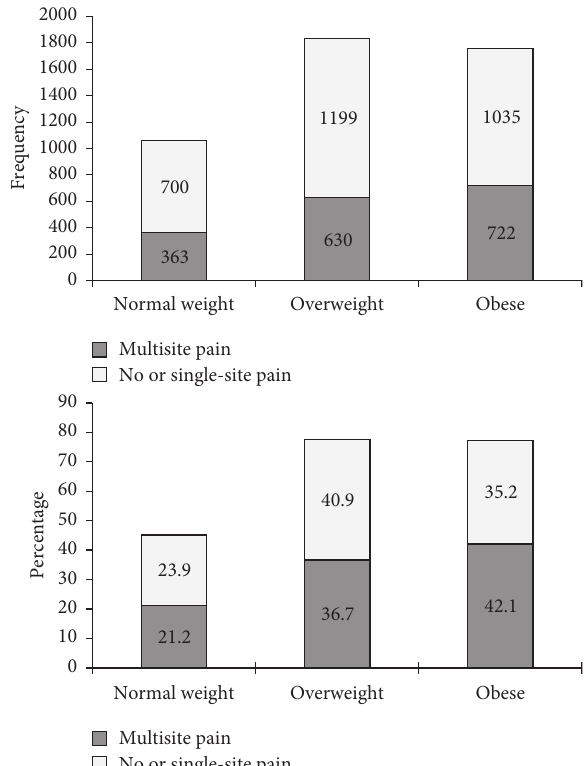
Figure 2: The distribution of frequency and percentages by pain status in the lower limbs between normal weight, overweight, and obese participants, n � 4,661. Cochran–Armitage test , p < 0 . 005